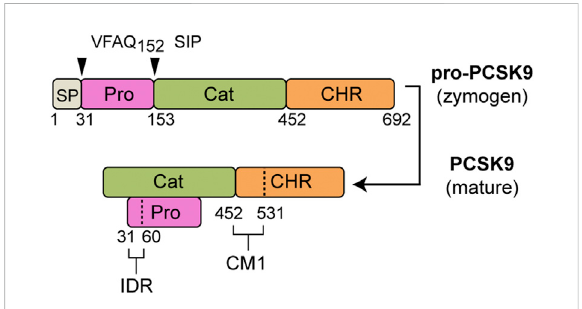
FIGURE 1 PCSK9 domain structure. Following removal of a signal peptide (SP: aa 1 – 30, grey) human pro-PCSK9 undergoes autocatalytic cleavage after Gln-152 resulting in mature PCSK9 consisting of a prodomain (Pro, aa 31 – 152, magenta), catalytic domain (Cat, aa 153 – 451, green) and CHR domain (aa 452 – 692, orange). Highlighted are two regions identi fi ed as important to LDL binding(Kosenko etal.,2013;Sarkaret